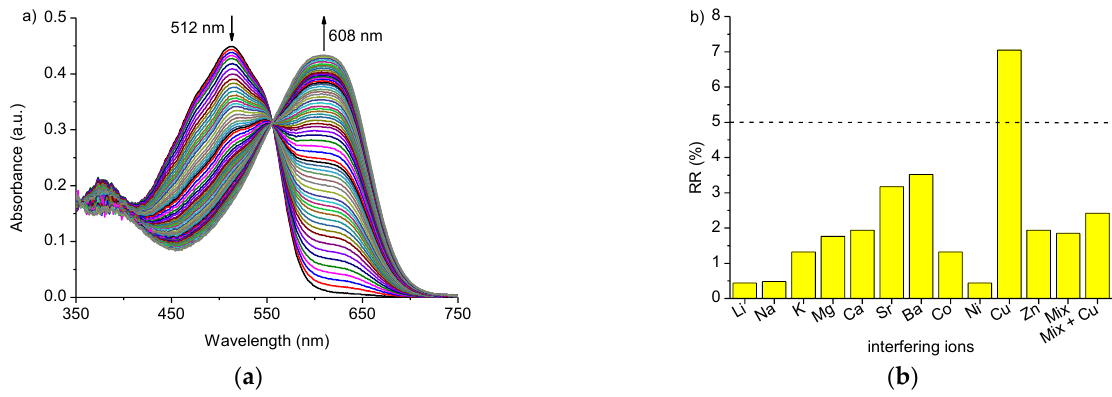
Figure 9. ( a ) Changes in the absorption spectrum of crown 3 (c 3 = 2.13 × 10 − 5 M) upon titration with lead(II) perchlorate (c Pb = 0-4.94 × 10 − 4 M); ( b ) interferences from several metal perchlorates at 10-fold molar excess on spectrophotometric response of 3 (c 3 = 2.13 × 10 − 5 M) at 608 nm at equimolar (to crown) amount of lead(II) perchlorate in acetonitrile:water (9:1, v/v) solution at pH 5.